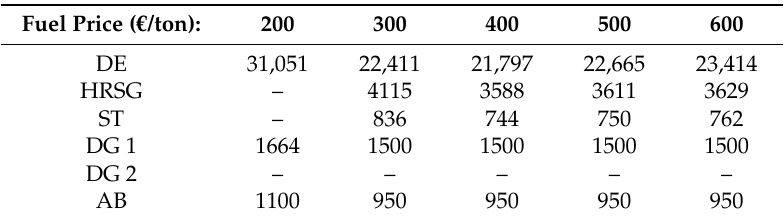
Table 36. Effect of fuel price on the optimal design specifications of the system for nominal freight rate price (the numbers give the nominal power in kW).